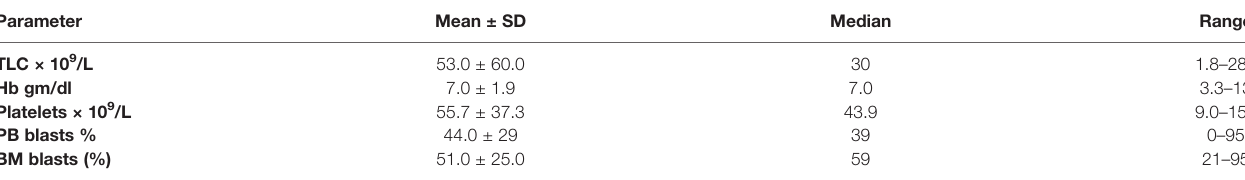
TABLE 1 | Hematological parameters in 84 newly diagnosed acute myeloid leukemia cases. Parameter